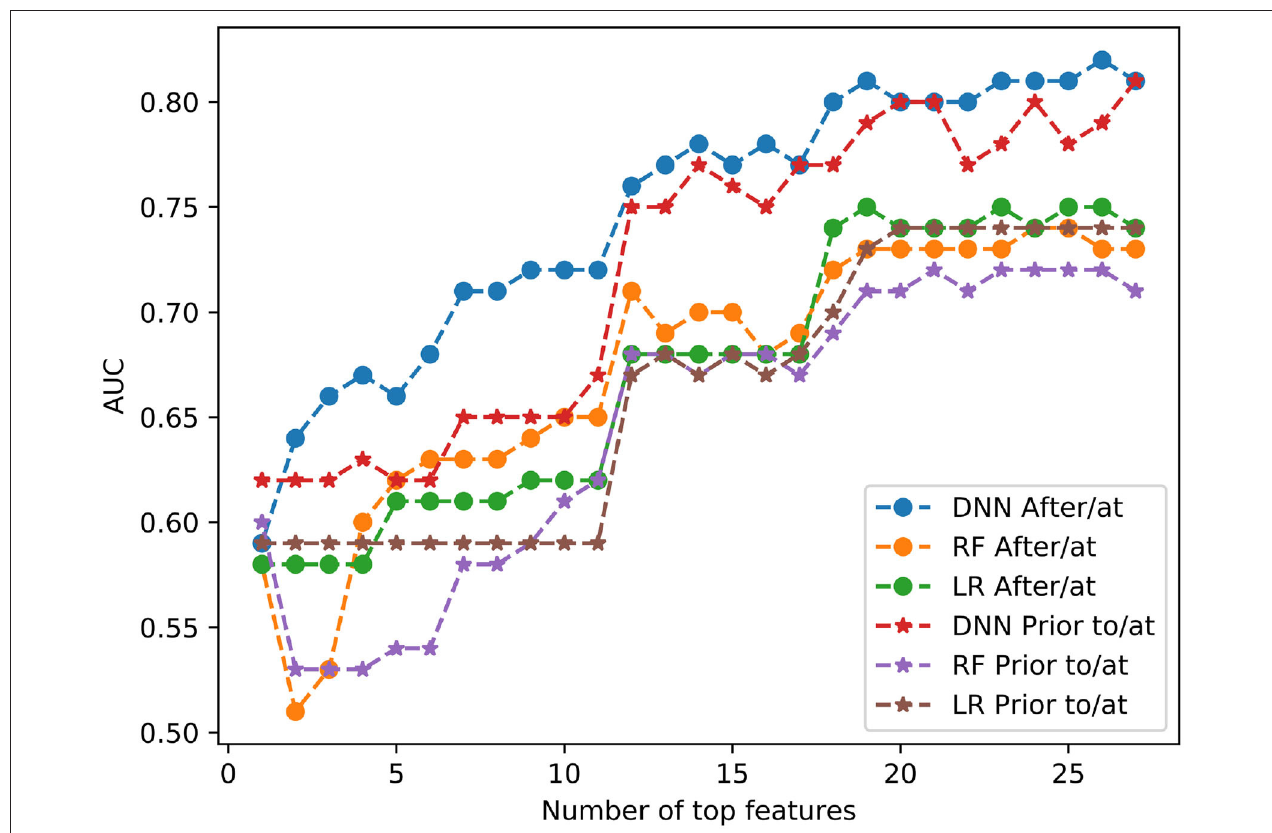
FIGURE 4 | Model performance with different numbers of top features for DNN, RF and